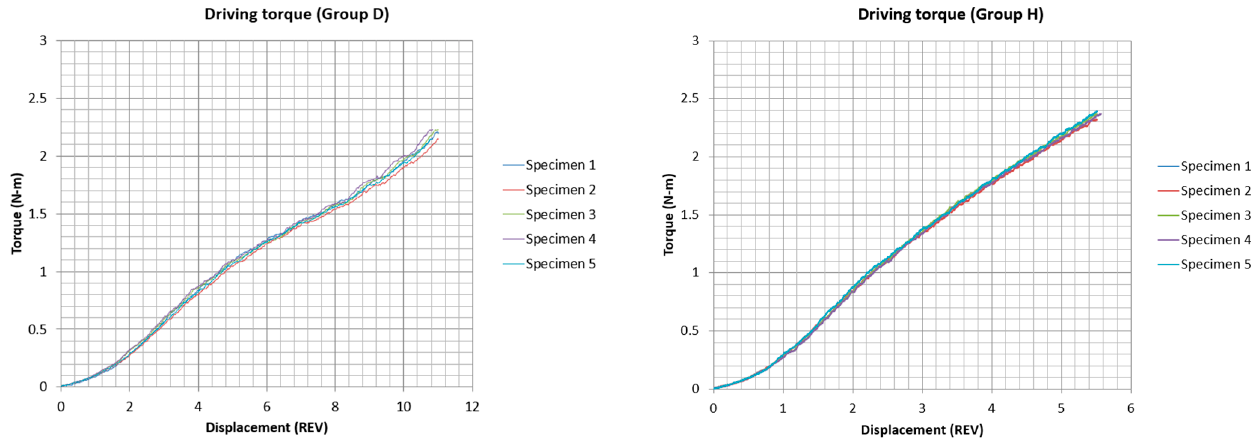
Figure 3. Bar chart of the mean insertion torque for each screw design. Error bars represent plus or minus one standard deviation.